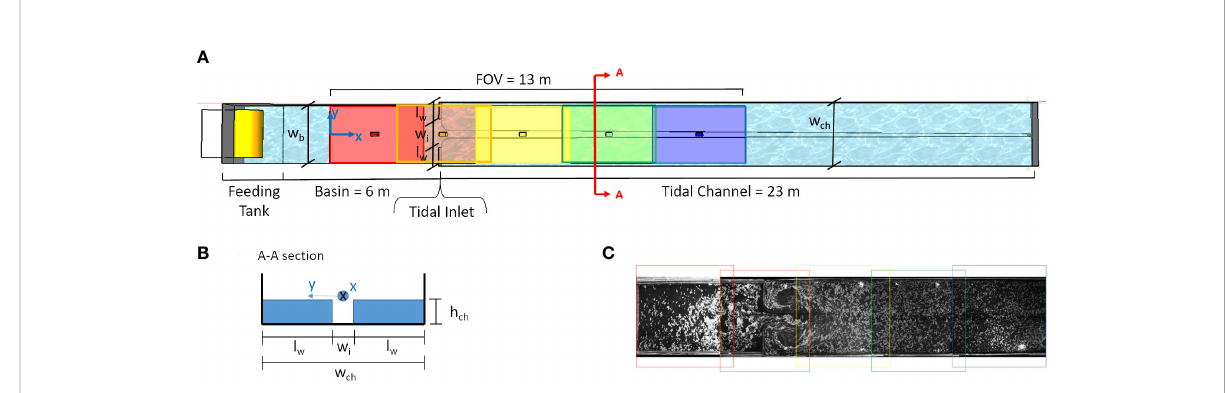
FIGURE 1 Panel (A) Sketch of the experimental set up and measuring systems. Panel (B) Sketch of channel cross-section. Panel (C) Example of panoramic view after merging process of the fi ve camera